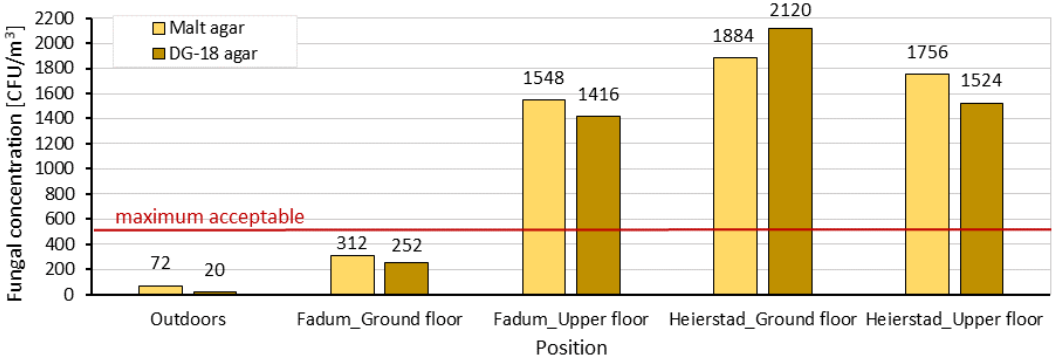
Figure 9. Fungal concentration in the two case studies considering the number of colony forming units found on the plates. The maximum acceptable value of 500 CFU/m 3 for noncontaminated indoor environments [43] is highlighted with the red line.